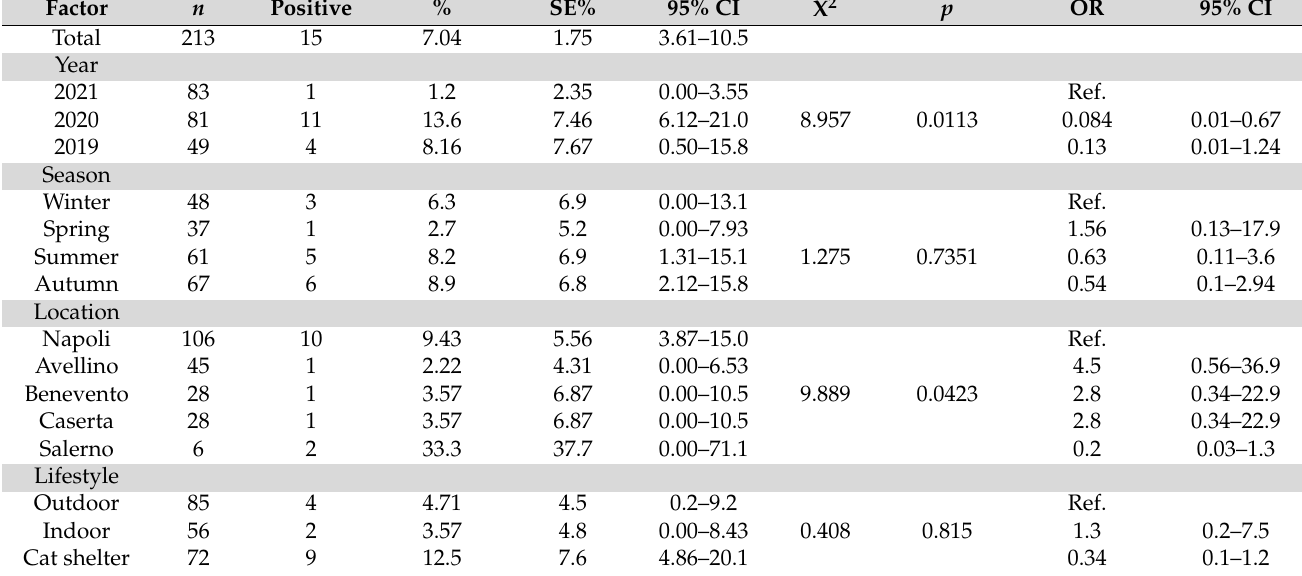
Table 8. Prevalence of infection of FCV and risk factor analysis (Campania Region,